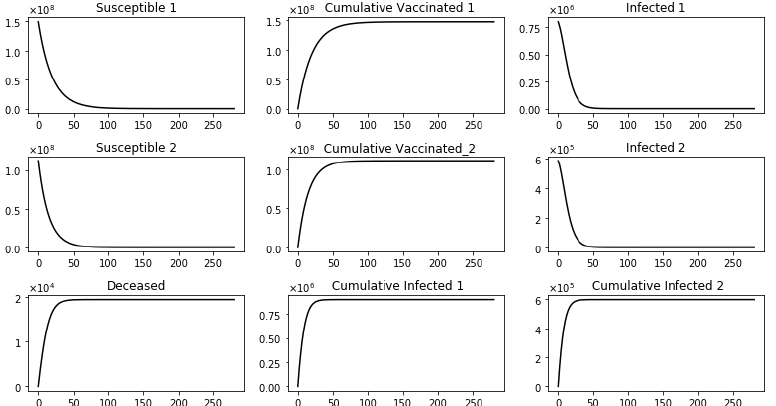
Figure 4. Dynamics of several subpopulations with a proportional vaccination rate program. This scenario considers a transmission rate such that the basic reproduction number R 0 is greater than